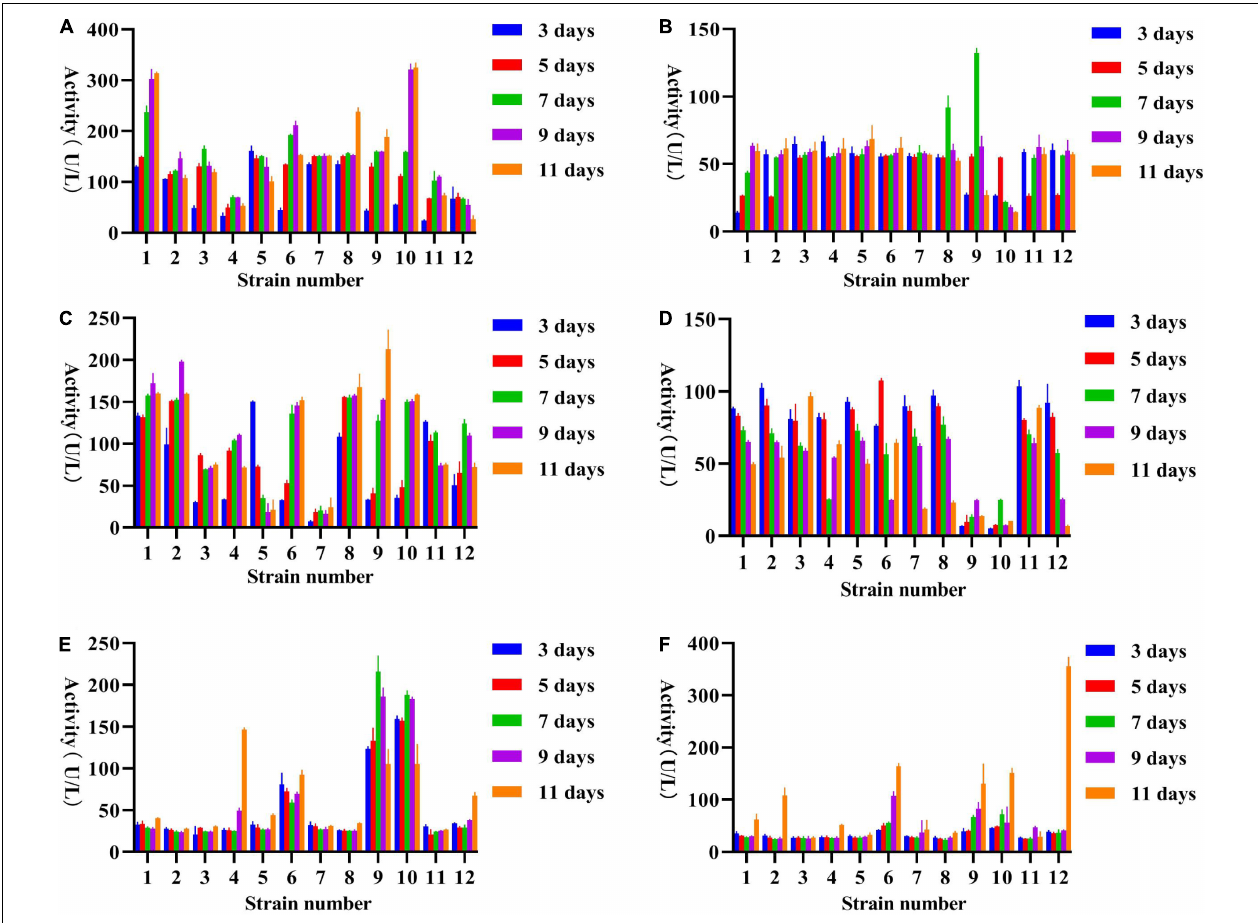
FIGURE 5 | Extracellular enzyme activities of sixteen fungal co-cultivation supernatant at days 3, 5, 7, 9, and 11 after inoculation in water with 6% anti-biodegradable residue; (A) β -glucosidase, (B) Cellulase, (C) β -xylosidase, (D) Xylanase, (E) Laccase, and (F) . Peroxidase. Three biological replicates were performed for each of the above